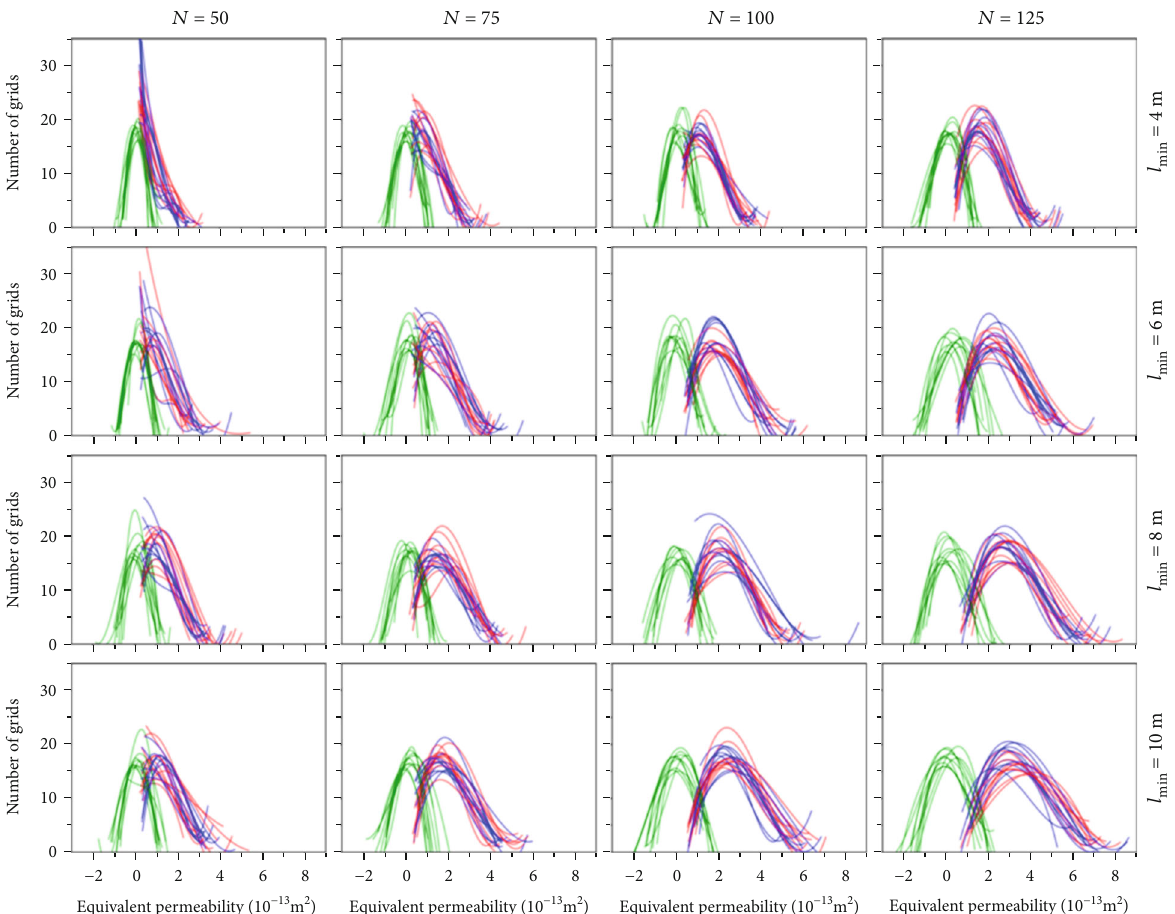
and N for all min